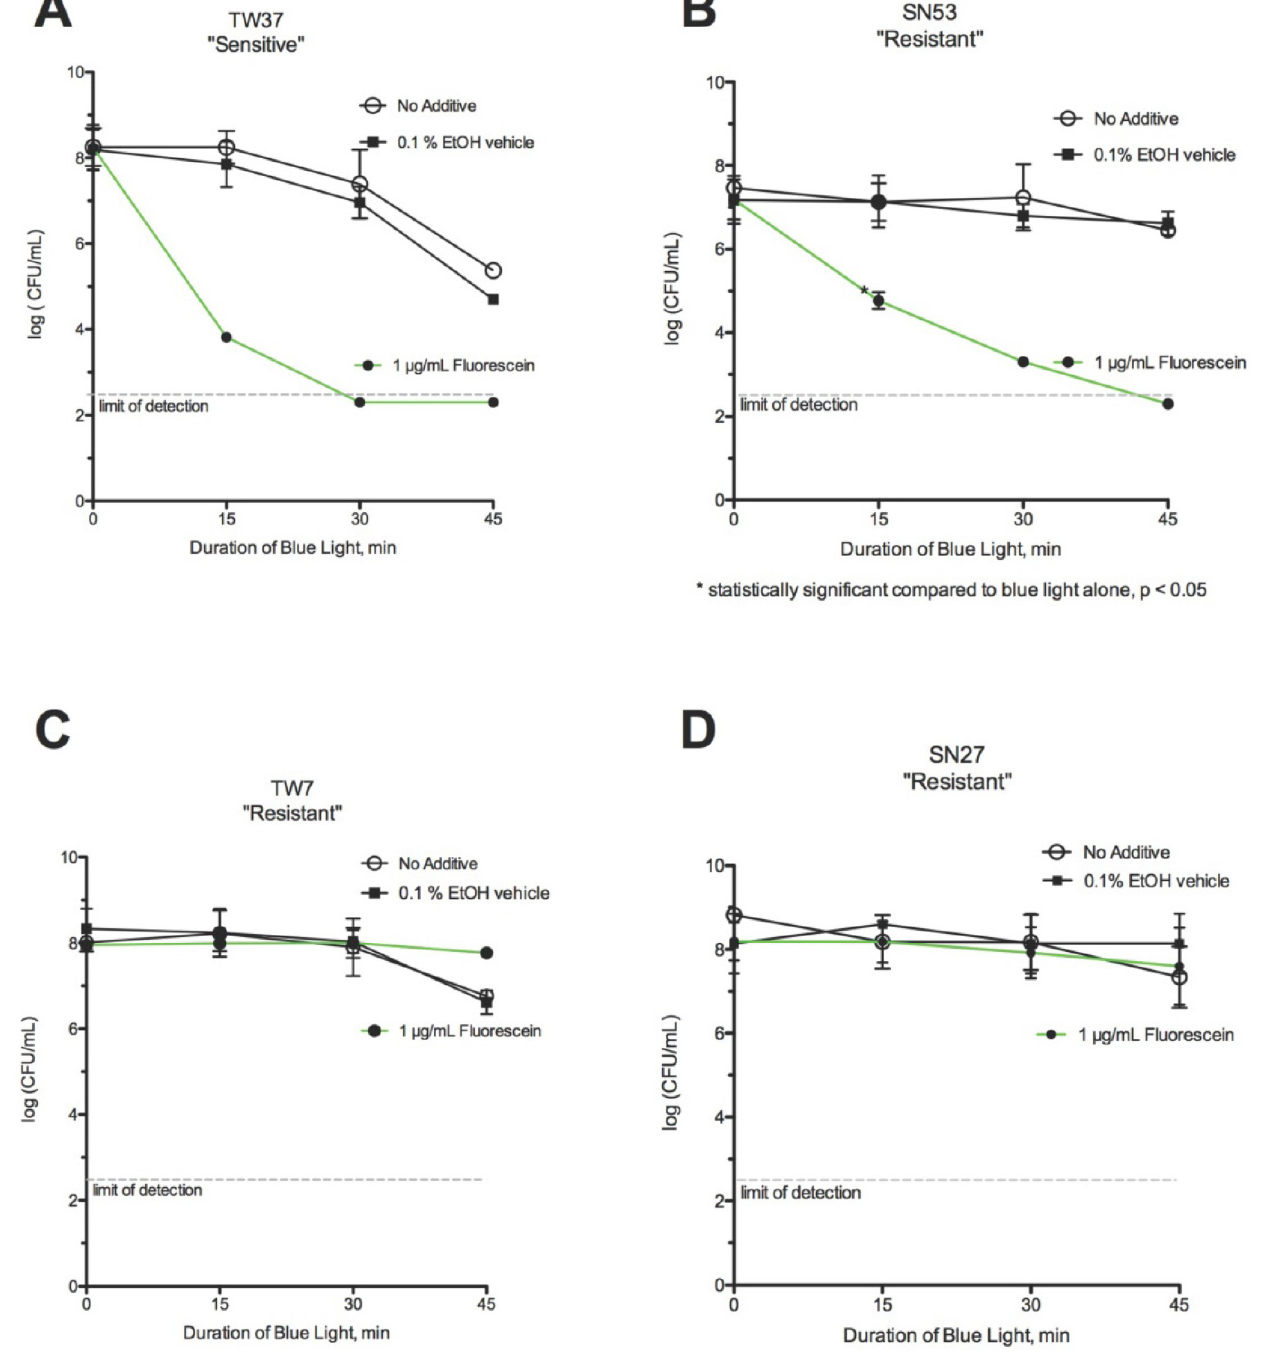
Figure 3. Effect of fluorescein and blue light. (A) Strain TW37 was Sensitive after 45 min of exposure to blue light alone, but was eradicated after 30 minutes in the presence of fluorescein . (B) In the presence of fluorescein, the Resistant strain SN53 could be eradicated by blue light following 45 minutes of exposure. Strains (C) TW7 and (D) SN27 remained Resistant to the combination of blue light with